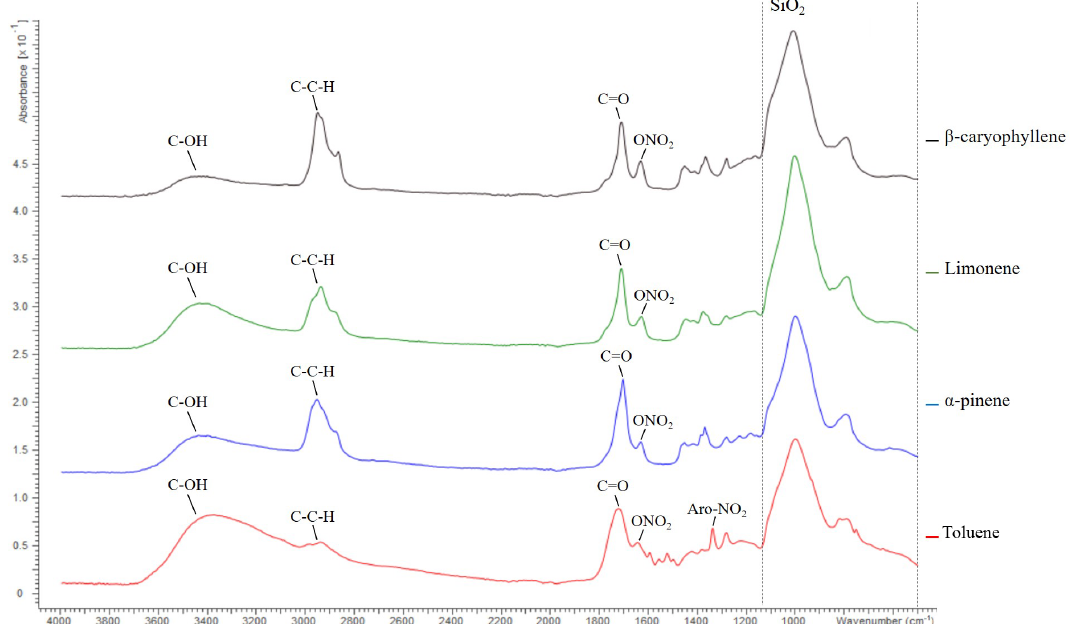
Figure 4. ATR-FTIR spectroscopy spectra of β -caryophyllene, limonene, α -pinene and toluene SOA displaying absorption frequencies of organic functional groups. The quartz filter (i.e. SiO 2 ) absorption region is highlighted by a dashed line; see the text for further information. Data from exps. 10, 24, 32 and 38; see Table 1. SOA was formed at 55% relative humidity with a VOC / NO x ratio of 3 for all SOA samples shown